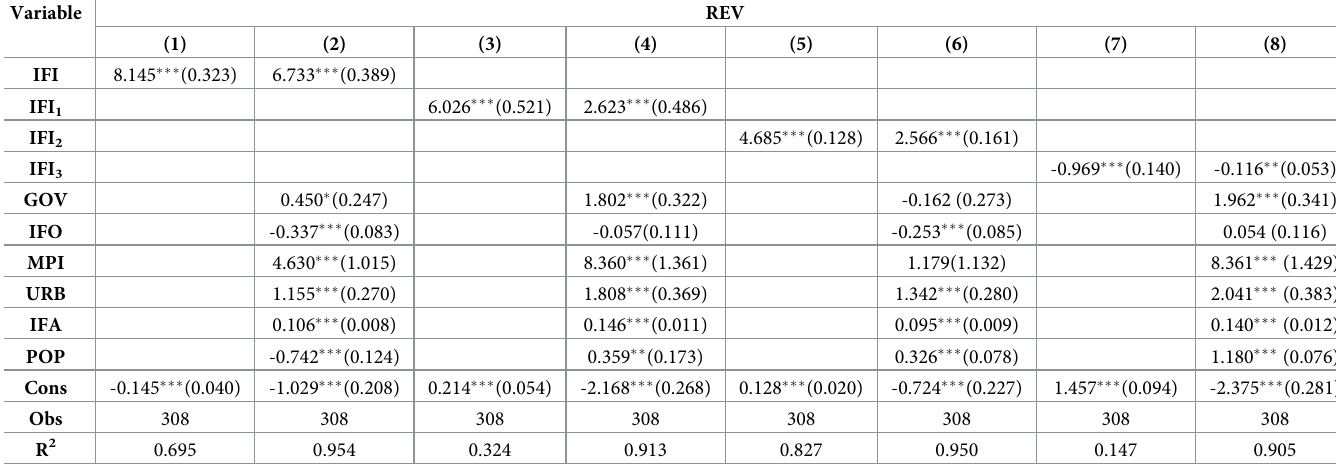
Table 8. Benchmark regression